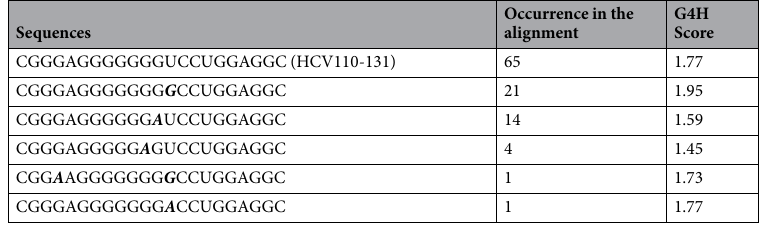
Table 1. G4 prone sequences detected by G4hunter. Mutations as compared to the most frequently found motif (HCV110-131) are shown in